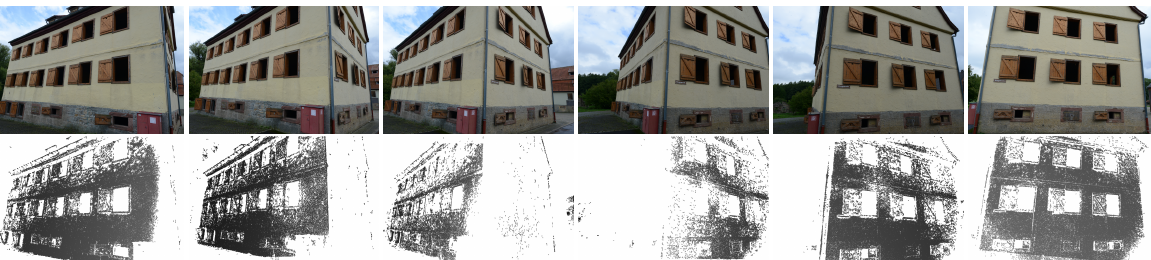
Figure 2. Six views on a building corner and the corresponding SGM outputs (depth maps). There are almost no commonly matched points between the third and the fourth image. But due to sufficiently many corresponding points between images 1 to 3, and 4 to 6, respectively, we are able to reconstruct dense building